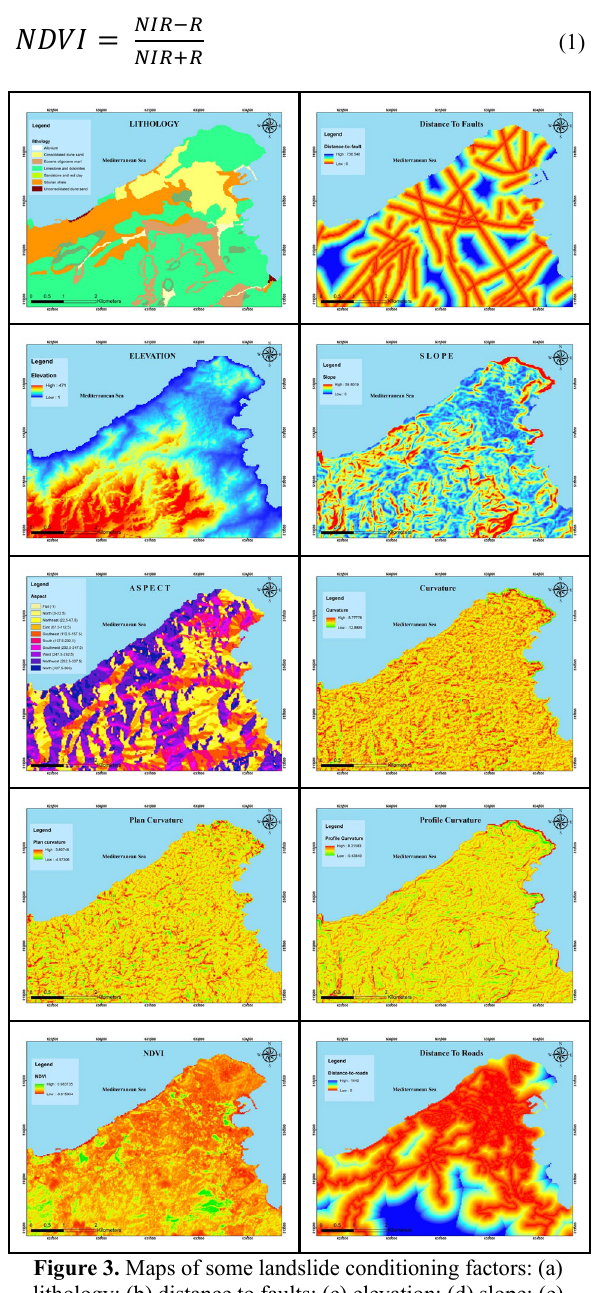
Figure 3. Maps of some landslide conditioning factors: (a) lithology; (b) distance to faults; (c) elevation; (d) slope; (e) aspect; (f) curvature; (g) plan curvature; (h) profile curvature; (i) NDVI; (j) distance to roads